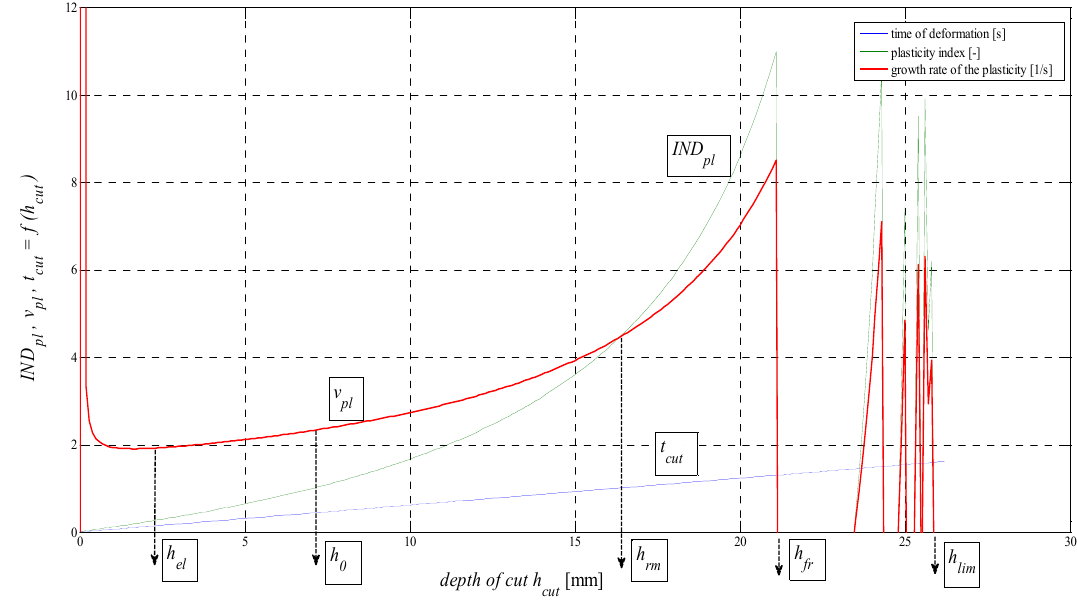
Figure 7. Analysis of f ( IND pl , v pl , t cut ) for AISI 304 material, E mat = 195 GPa.